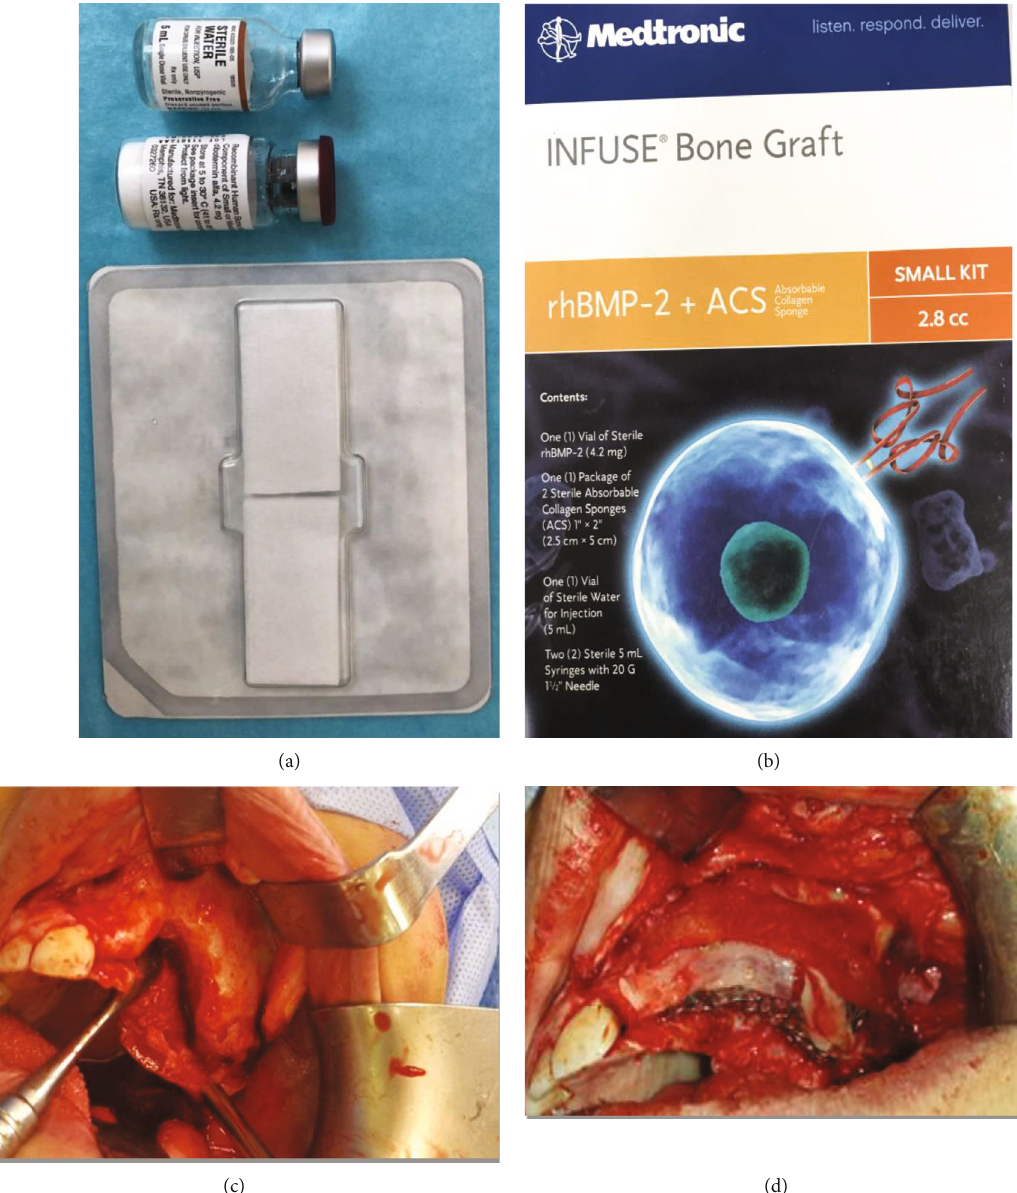
Figure 2: (a) Bone marrow aspirate concentrate. (b) Recombinant human bone morphogenetic protein 2 (rhBMP-2). (c) Maxillary extraosseous vertical ridge defect. (d) rhBMP-2, allograft, and bone marrow aspirate concentrate condensed inside prepared mesh covered by the platelet-rich fi